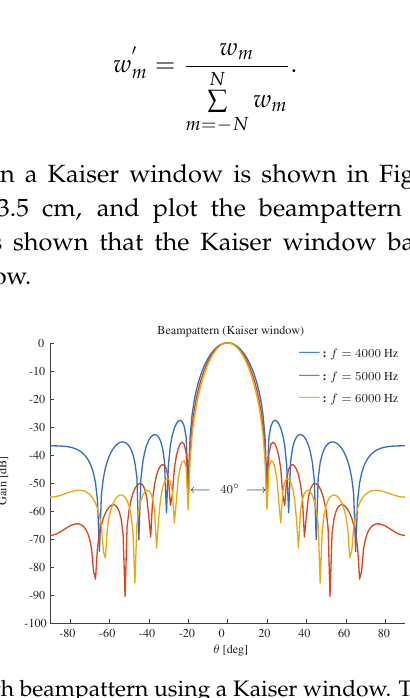
Figure 5. Constant beamwidth beampattern using a Kaiser window. The beamwidth is fixed to 40 ◦ , M = 11, δ = 3.5